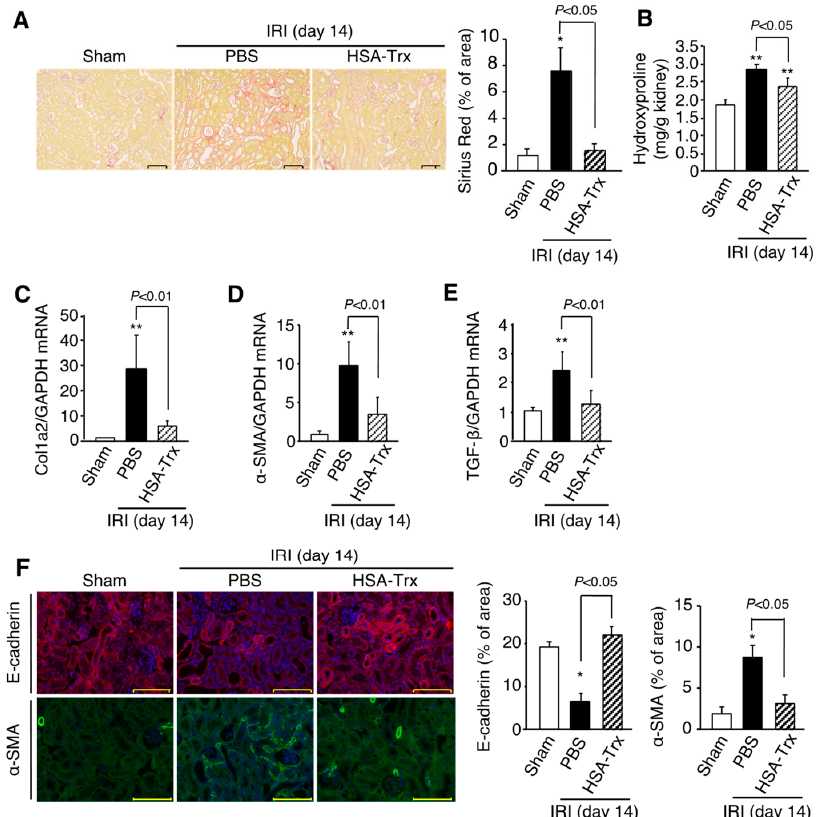
Figure 2. Effect of HSA-Trx against renal fibrosis and the epithelial-mesenchymal transition in renal IR-treated mice on 14 days after IR. ( A ) Representative photomicrographs and quantification of Sirius red-stained kidney sections are shown on 14 days after renal IR. Original magnifications: ×200. Scale bars represent 100 μ m. ( B ) Hydroxyproline content in kidney were measured on 14 days after renal IR. ( C ) mRNA expression of (C) Col1a2, ( D ) α -SMA ( α -smooth muscle actin) and ( E ) TGF- β in kidney on 14 days after renal IR were determined by real-time PCR. Effect of HSA-Trx against epithelial-mesenchymal transition (EMT) in renal IR-treated mice on 14 days after IR: ( F ) Representative photomicrographs and quantification of immunostaining of renal E-cadherin and α -SMA are shown on 14 days after renal IR. Cells were also treated with DAPI (blue) in E-cadherin and α -SMA immunostaining. Original magnifications: ×400. Scale bars represent 100 μ m. Data are expressed as the mean ±SD ( n = 5). * p < 0.05, ** p < 0.01 compared with sham mice.